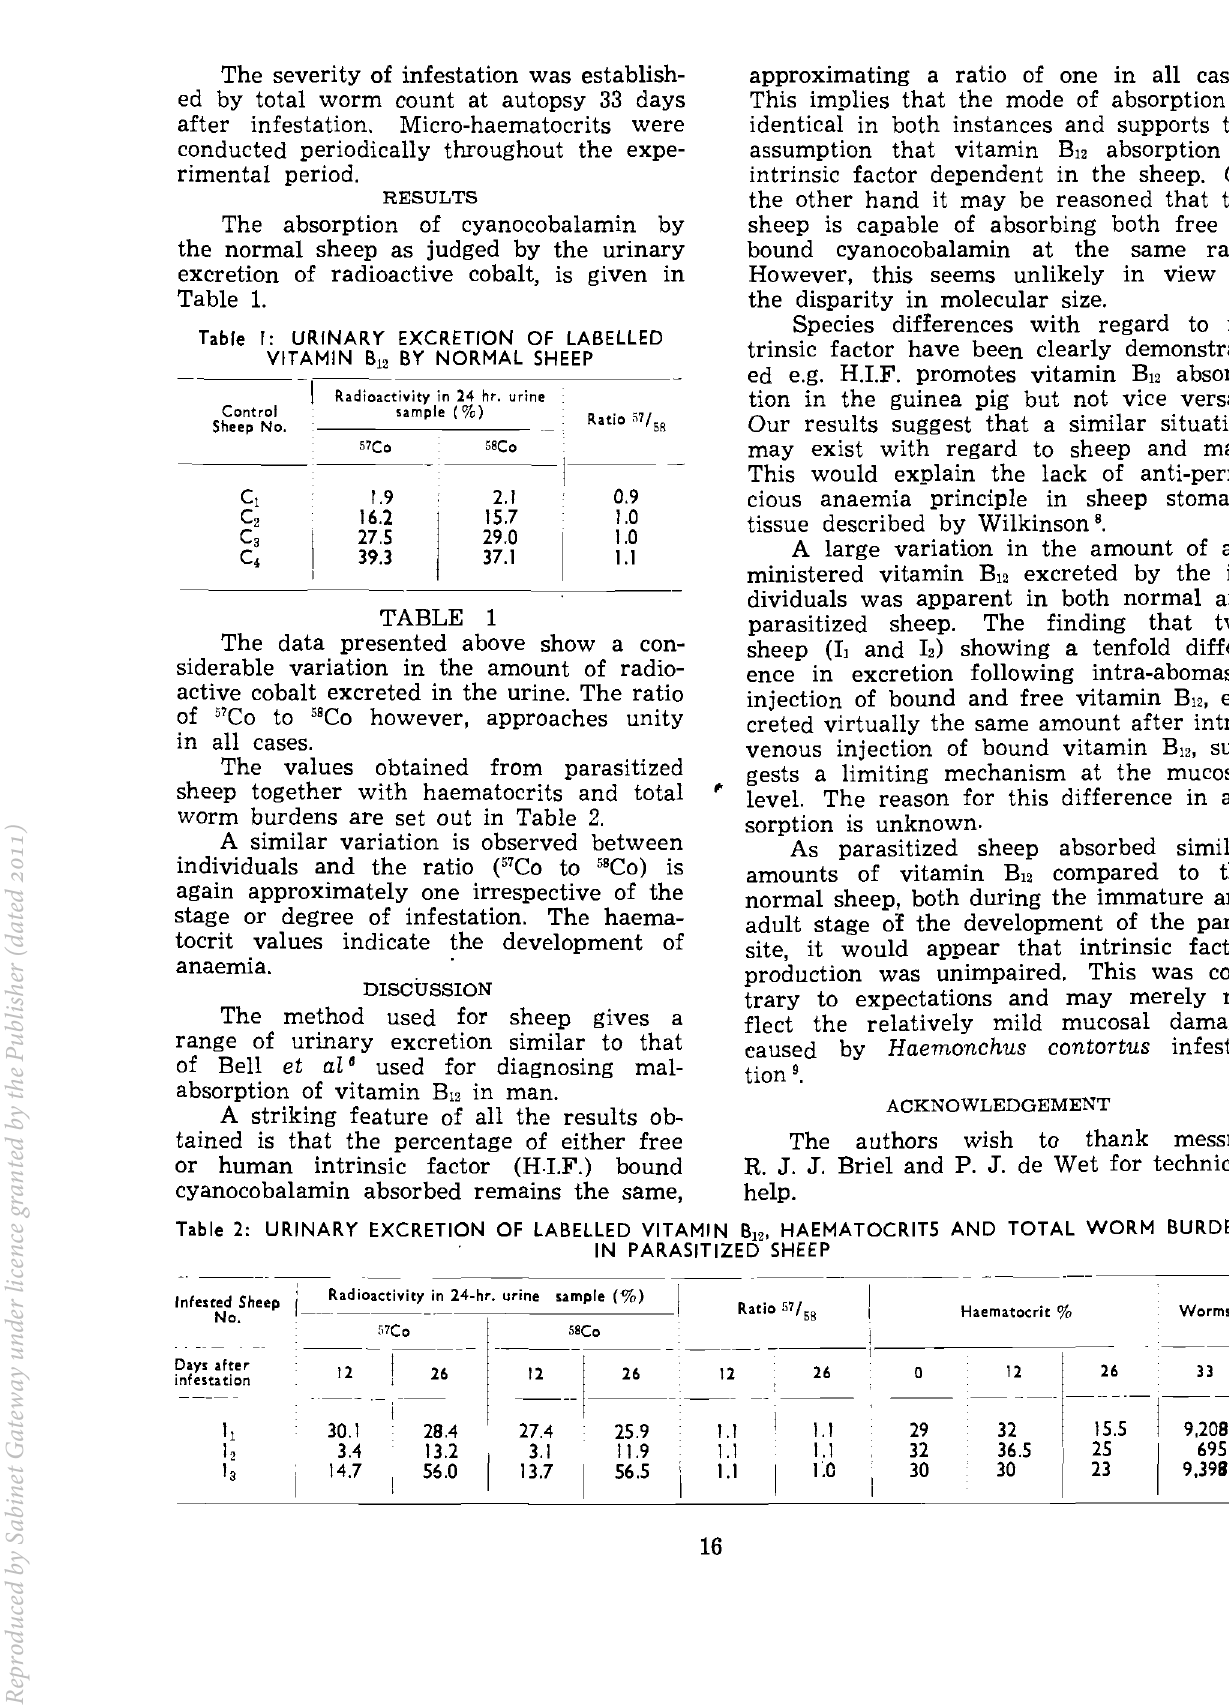
IN PARASITIZED SHEEP